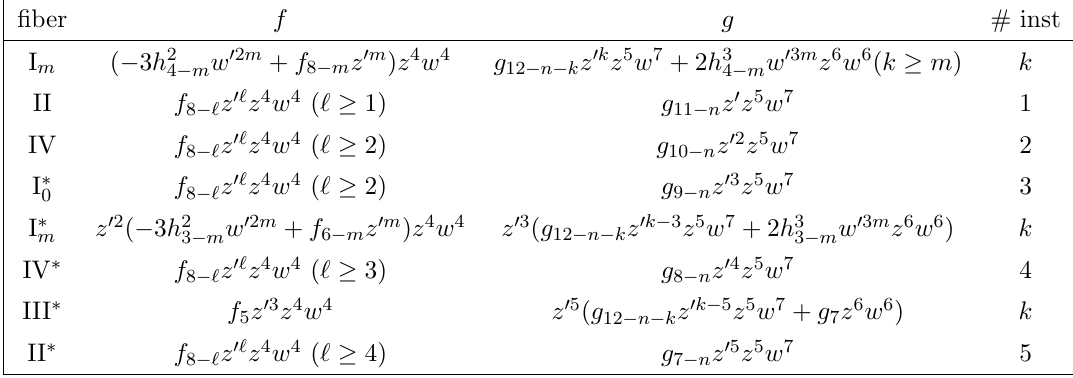
Table 2. Coalescent k small instantons of E 8 , given by (local) ADE singularities at z 0 = 0